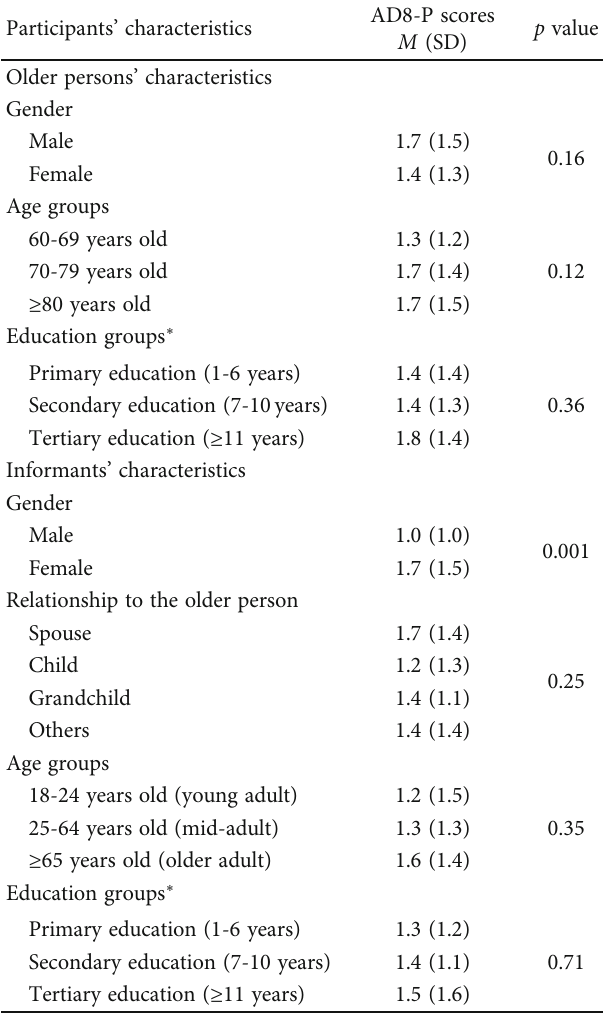
Table 5: Comparisons of mean AD8-P scores strati fi ed by the older persons ’ and informants ’